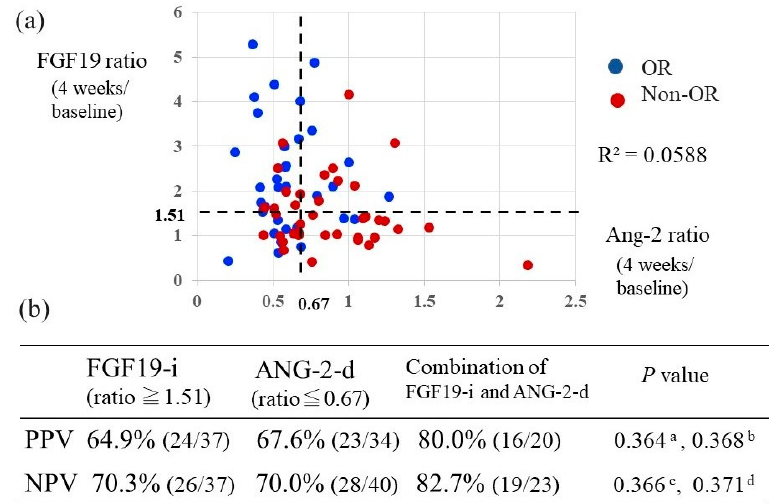
Figure 3. Relationship between changes in FGF19 and Ang-2 levels and predictability of response to Lenvatinib treatment. ( a ) Correlation between the ratio (at 4 weeks / baseline) of serum levels of fibroblast growth factor (FGF) 19 and angiopoietin-2 (Ang-2) with Lenvatinib treatment. R², coefficient of determination ( b ) Positive predictive value (PPV) and negative predictive value (NPV) of Lenvatinib response using the cut-off ratio of fibroblast growth factor (FGF) 19 and angiopoietin-2 (Ang-2) determined in this study. a , PPV of both FGF19-i and Ang-2-d vs. PPV of FGF19-i; b , PPV of both FGF19 and Ang-2 vs. PPV of Ang-2-d; c , NPV of both FGF19-i and Ang-2-d vs. NPV of FGF19-i; d , NPV of both FGF19-i and Ang-2-d vs. NPV of Ang-2-d.